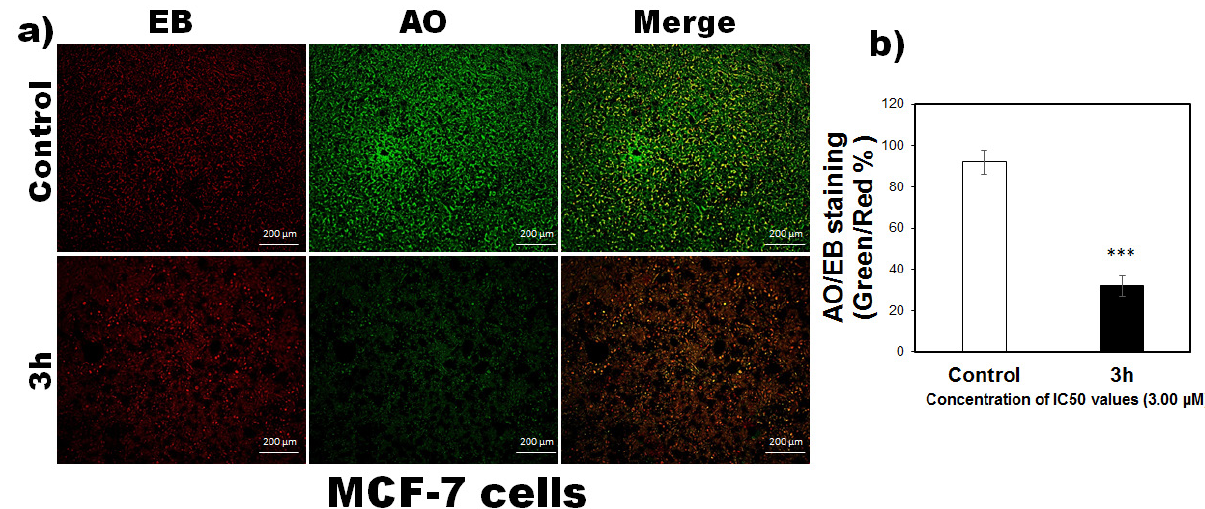
Figure 1 . MCF-7 cells treated with 3.00 µM concentration of compound 3h , a) AO/EB staining in floresance imaging b) AO/EB staining ratio (*** p < 0.001 vs control)